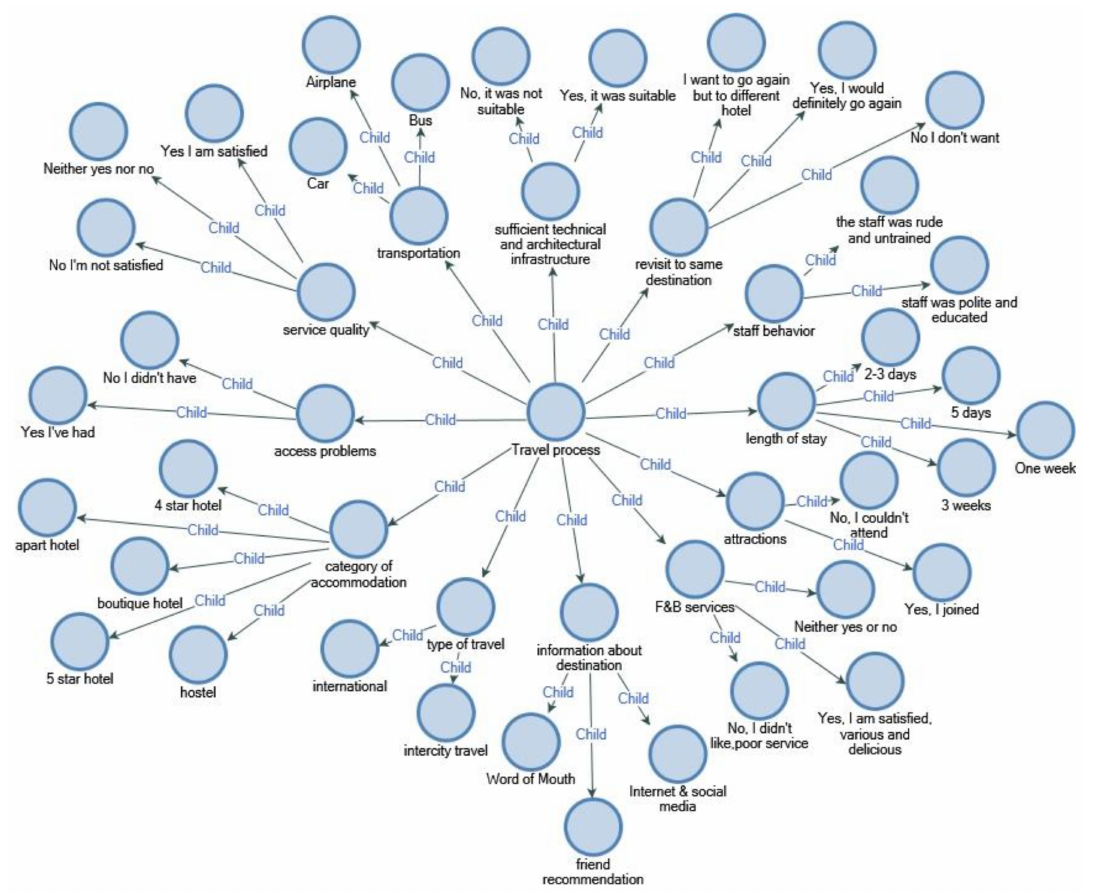
Figure 5. Travel